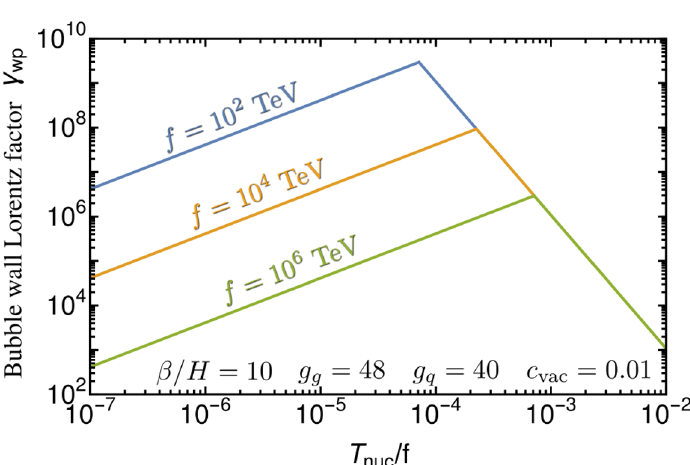
Figure 5 . The Lorentz factor of the wall at bubble percolation for various values of f and amounts of supercooling, assuming β/H = 10 . For extreme supercooling (on the left side of the plot) γ is in the runaway regime. In this regime, larger f or smaller T which the bubble can accelerate. The former because of the smaller Hubble horizon and the latter due to the larger bubble size at nucleation. Therefore γ Linear